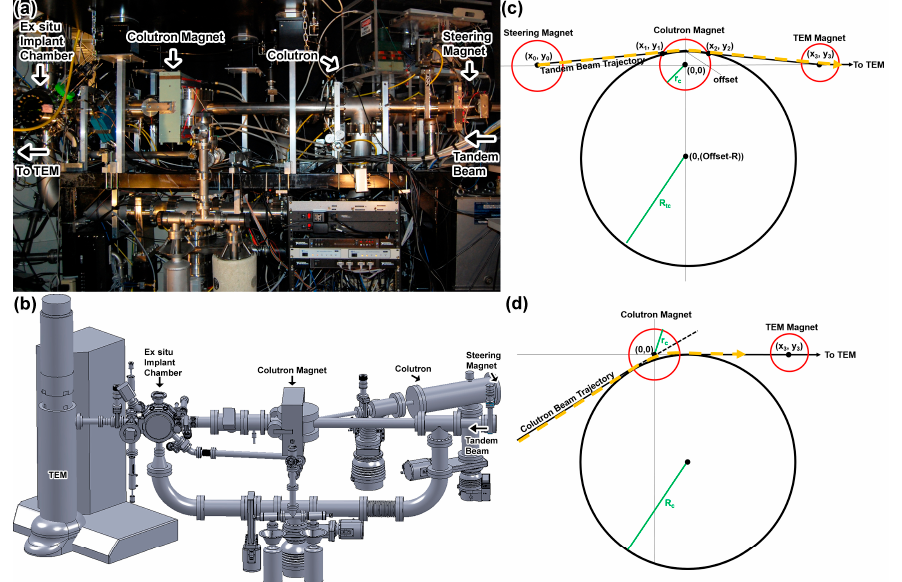
Figure 1. Diagrams showing the I 3 TEM facility, starting with ( a ) an image of the beam line, marked with arrows to show the Colutron magnet, Tandem electrostatic steerers and the original locations of the Colutron and Tandem beams; ( b ) a Solid Works drawing of the beam line in (a), clearly showing the Colutron and Tandem beam lines joining at the Colutron magnet; ( c ) the Tandem beam trajectory through the Colutron magnet; and ( d ) the Colutron beam trajectory through the Colutron magnet, indicated clearly with dashed yellow lines.